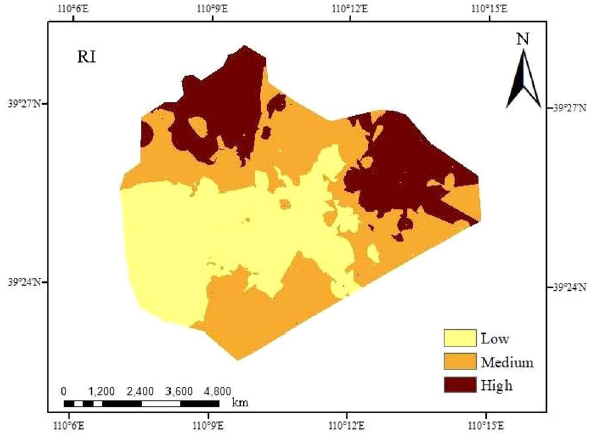
Figure 4. Spatial distribution of RI of heavy matals(created by Arcgis 10.8, http:// deskt op. arcgis. com/ cn/).